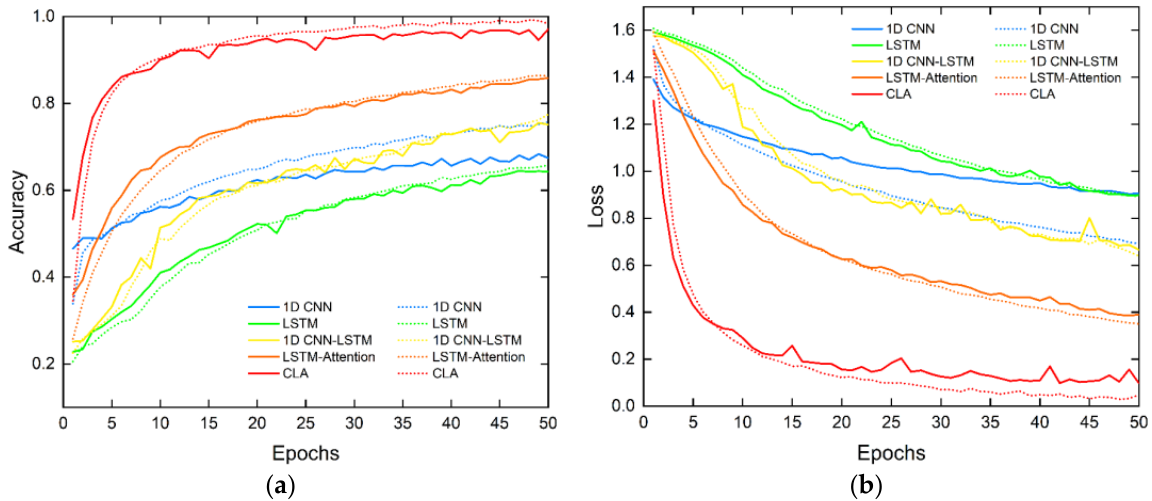
Figure 12. ( a ) Curves of training and validating accuracy varying with the number of epochs for different networks in ablation experiments; ( b ) curves of training and validating loss varying with the number of epochs for different networks in ablation experiments. (The solid line represents the validating curve; the dotted line represents the training curve).